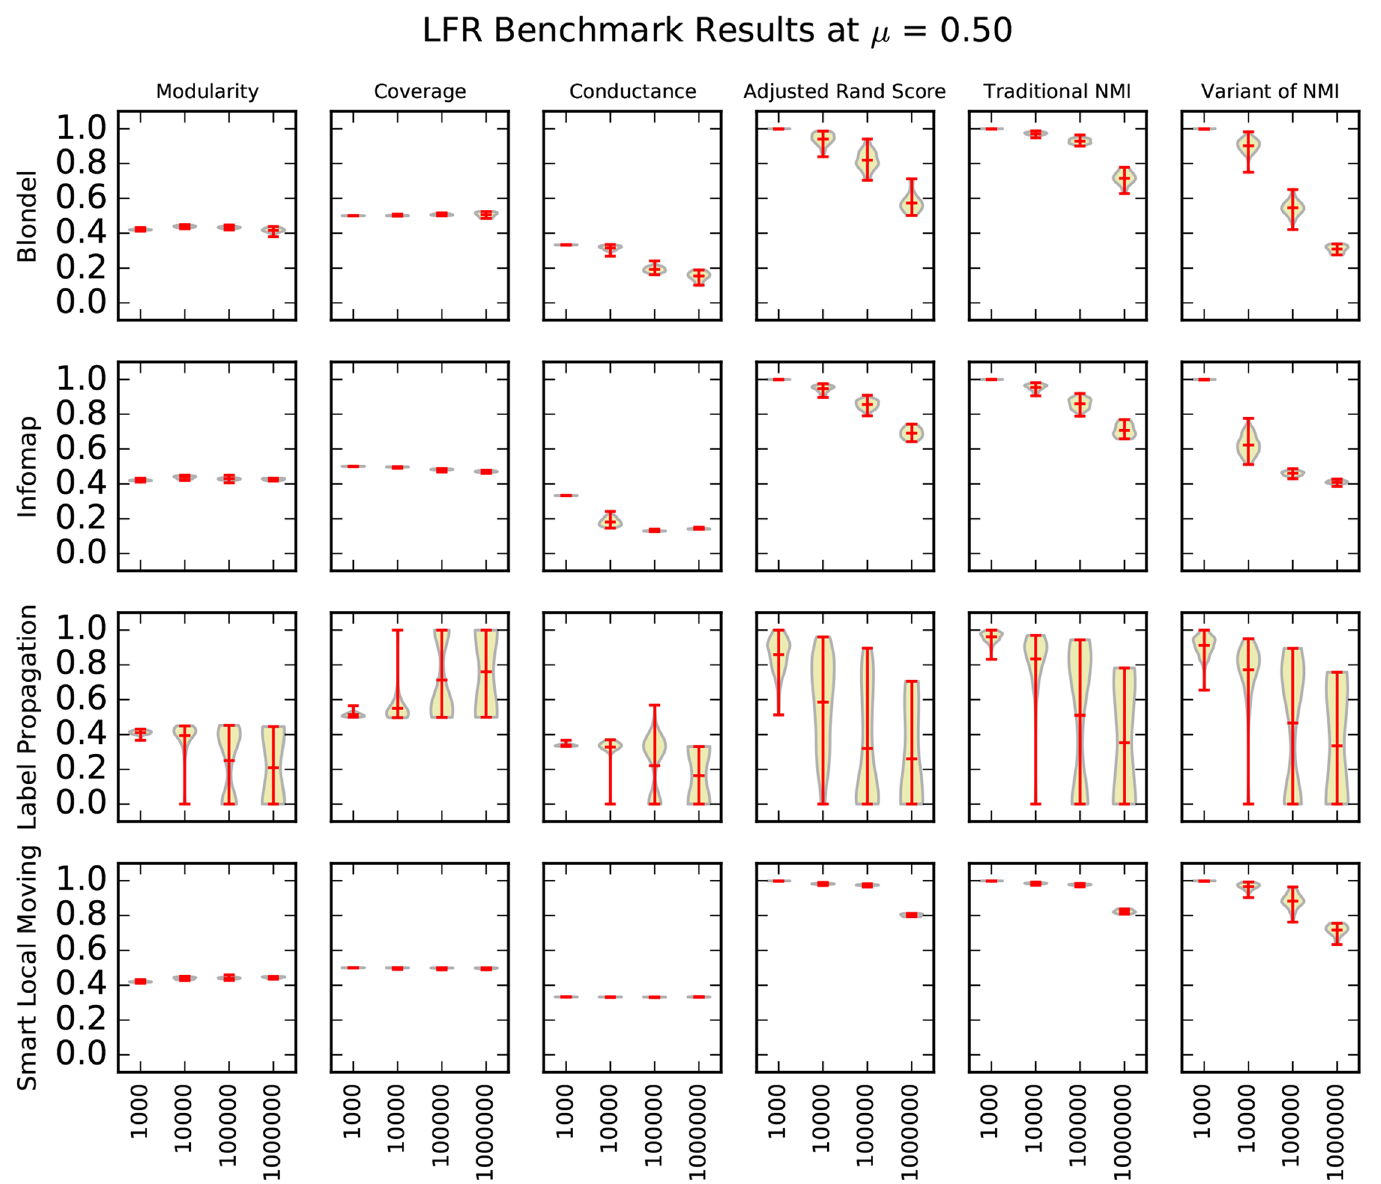
Fig 5. A matrix of violin plots illustrating the synthetic graph experiment results at μ = 0.50. We drew each “ violin ” using a Gaussian kernel density estimation. Red lines indicate the minimum, maximum, and mean of the